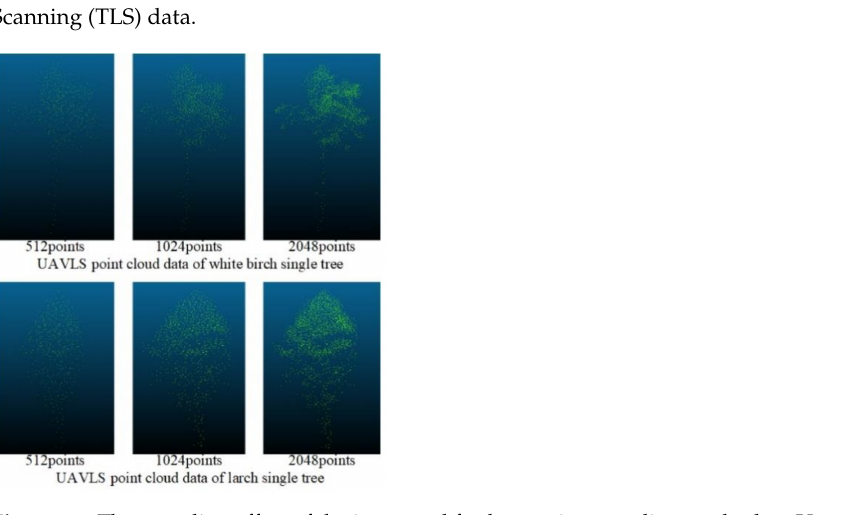
Figure 10. The sampling effect of the improved farthest point sampling method on Unmanned Aerial Vehicle Laser Scanning (UAVLS)